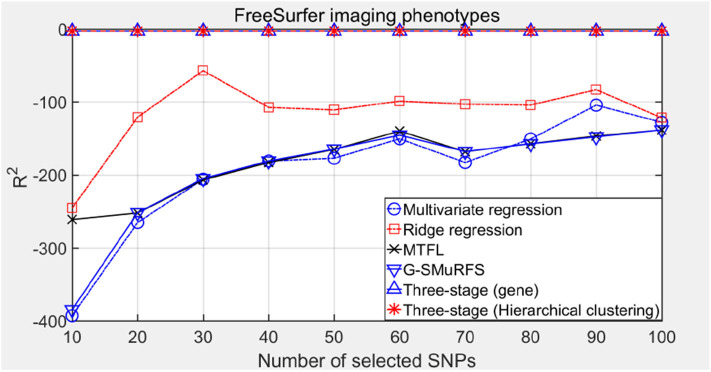
The comparison results on R2.